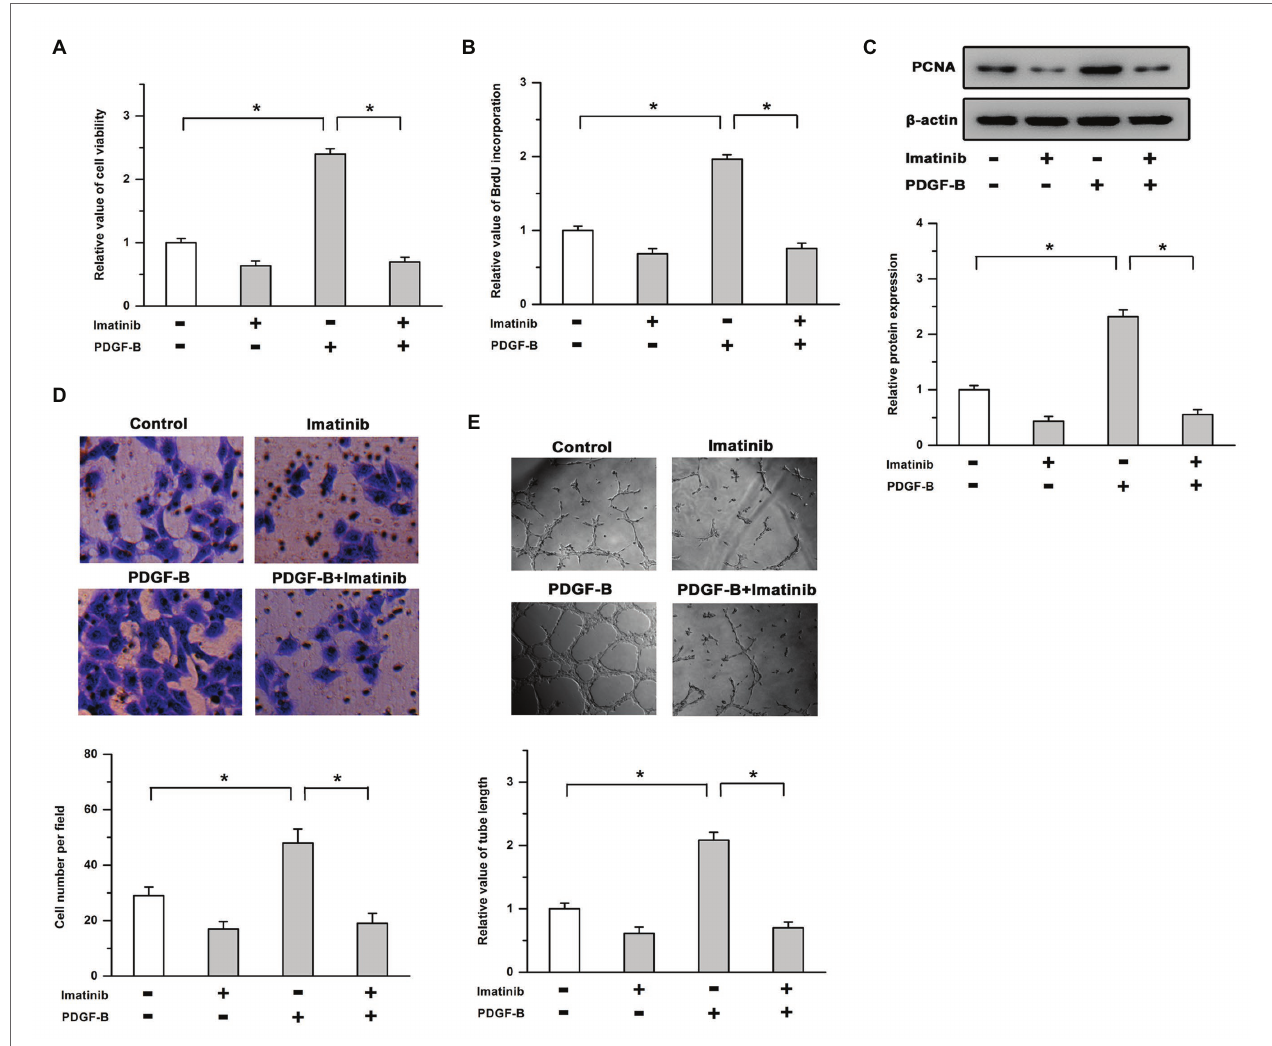
FIGURE 1 | Activation of the platelet-derived growth factor-B/PDGF receptor pathway promotes cell proliferation and angiogenesis. (A,B) The increased cell viability (A) and bromodeoxyuridine (BrdU) incorporation (B) induced by PDGF-B were mitigated by the inhibition of PDGFR. (C) PDGF-B-induced proliferating cell nuclear antigen (PCNA) expression was attenuated by imatinib. (D,E) Treatment with PDGF-B facilitated cell migration (D) and tube formation (E) which were mitigated by imatinib. *indicates p <